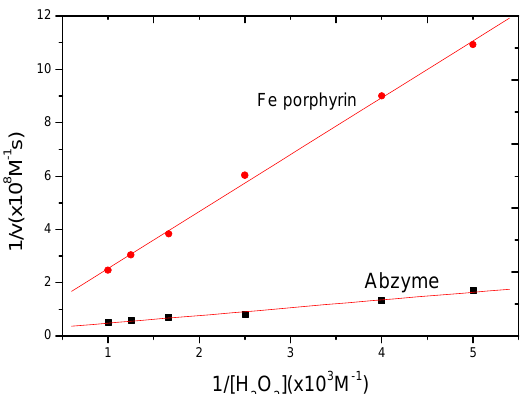
Figure 5 . Lineweaver-Burk plot for the relationship between the rate of chlorination and H concentration.The reaction mixture contains 300 µ moles of PBS, pH 2.75; 60 µ moles KCl; 0.6~3.0 µ moles H O ; 0.3 µ mole monochlorodimedon; 0.1 µ M Fe porphyrin-MAb 1F2 (1:1) in a total 2 2 volume of 3